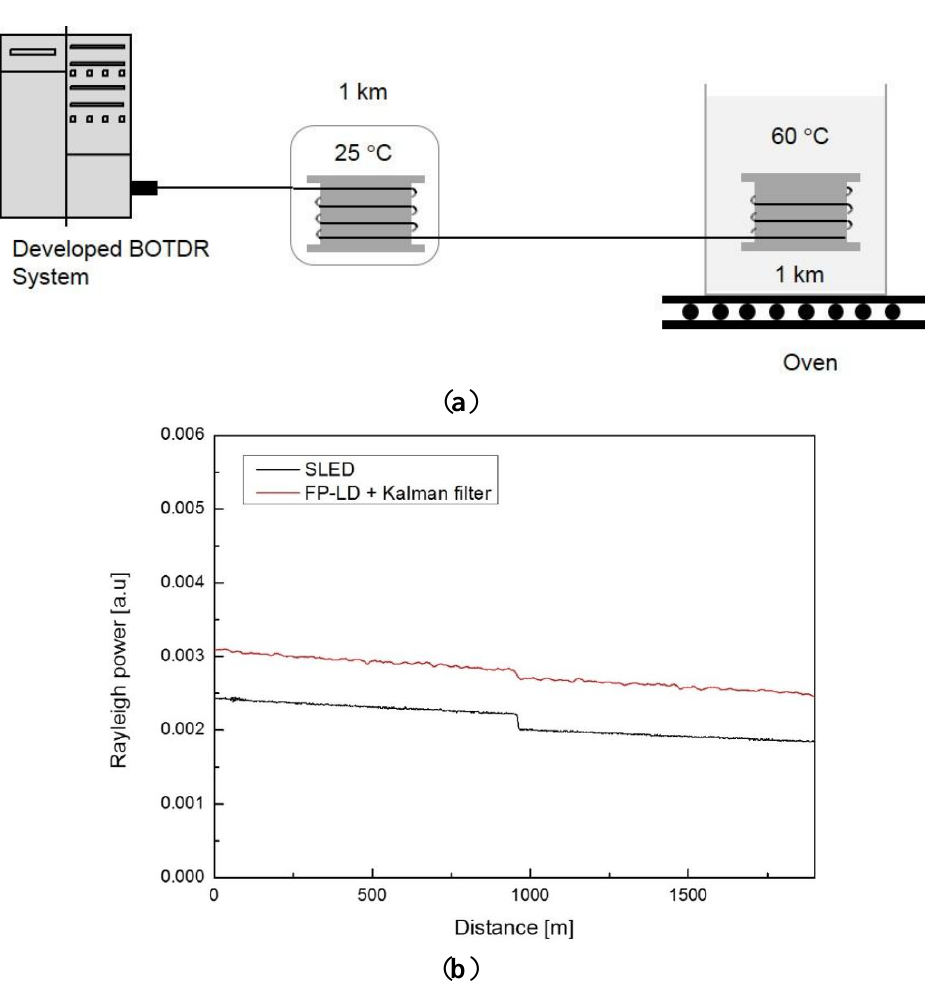
Figure 7. ( a ) Experimental setup and ( b ) comparison of FP-LD and SLED based OTDR trace for evaluating the